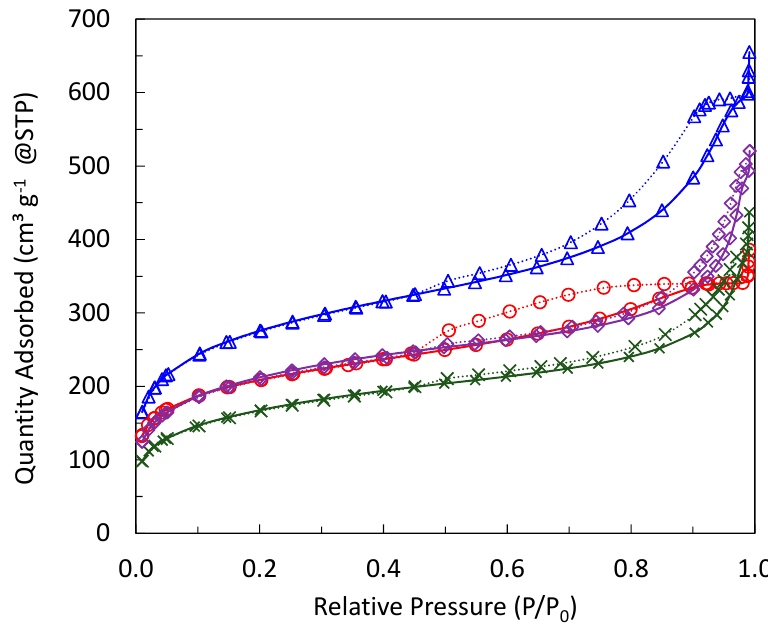
), Si NHSG ( ♦ ), and4Ta IMP Si-2Ag (cid:35)